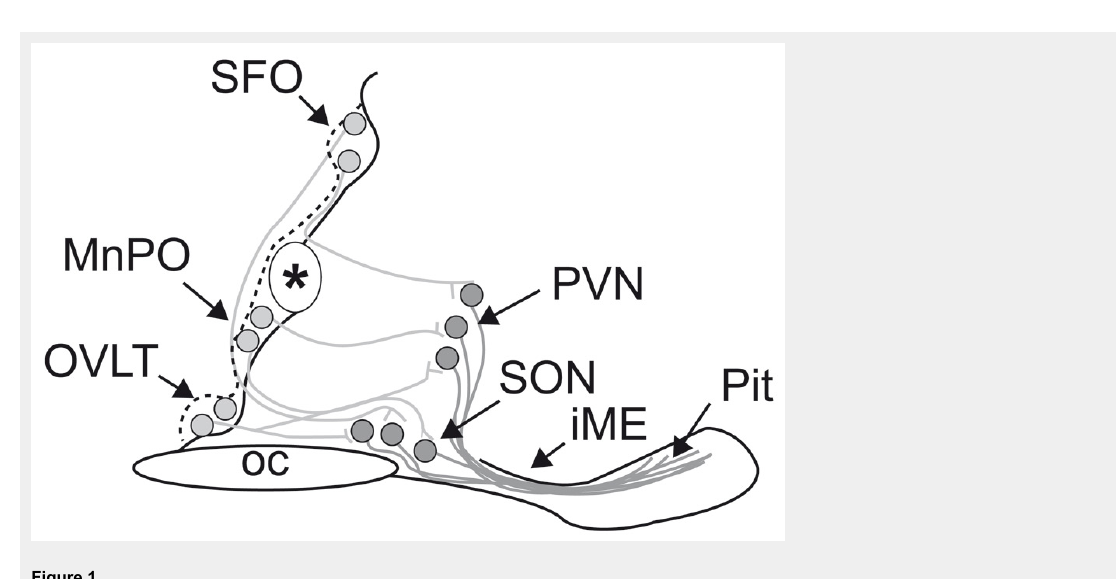
Schematic representation of the osmoregulatory pathway of the hypothalamus (sagittal section of midline of ventral brain around the 3rd ventricle in mice). Neurons (lightly filled circles) in the lamina terminalis (OVLT), median preoptic nucleus (MnPO) and subfornical organ (SFO) – that are responsive to plasma hyptertonicity send efferent axonal projections (grey lines) to magnocellular neurons of the paraventricular (PVN) and supraoptic nuclei (SON). The OVLT is one of the brain circumventricular organs and is a key osmosensing site in the mammalian brain (vide infra). The processes (dark lines) of these magnocellular neurons form the hypothalamo-neurohypophysial pathway that courses in the median eminence to reach the posterior pituitary, where neurosecretion of vasopressin and oxytocin occurs. (Modified from [80]).